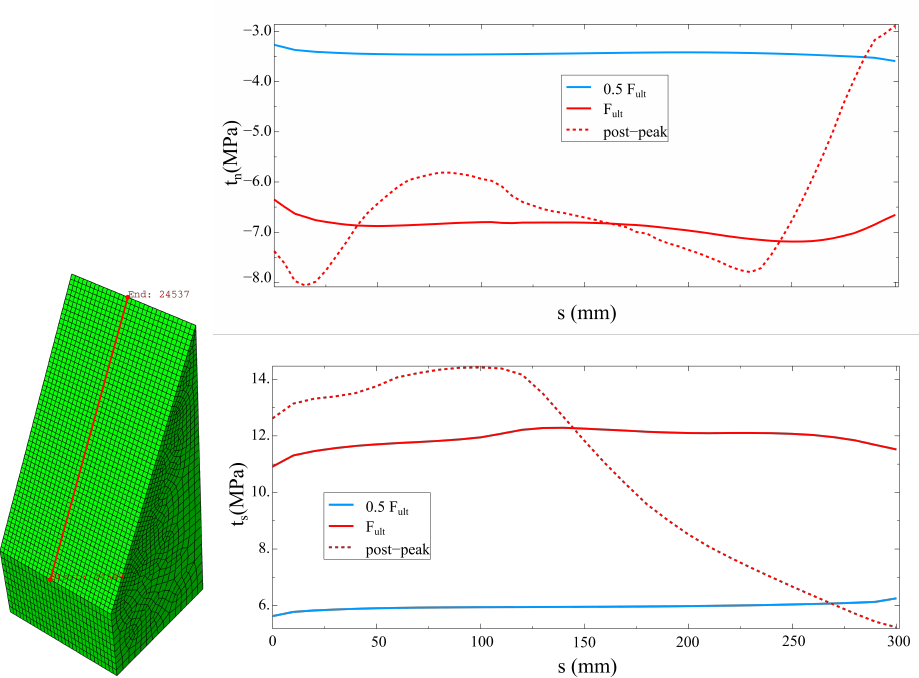
Figure 22. Distributions of normal and tangential tractions along the selected